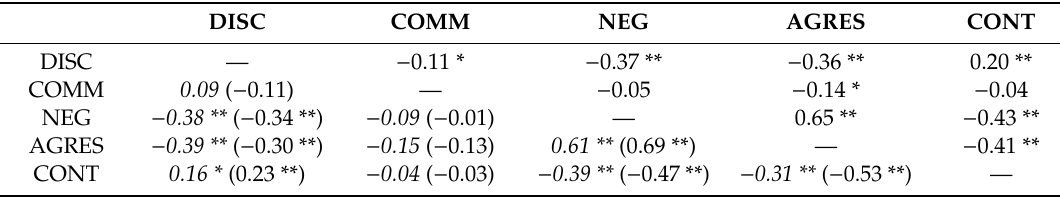
Table 2. Correlations in the total sample (above diagonal) and by gender (below diagonal) in the 1–3 year-old group.